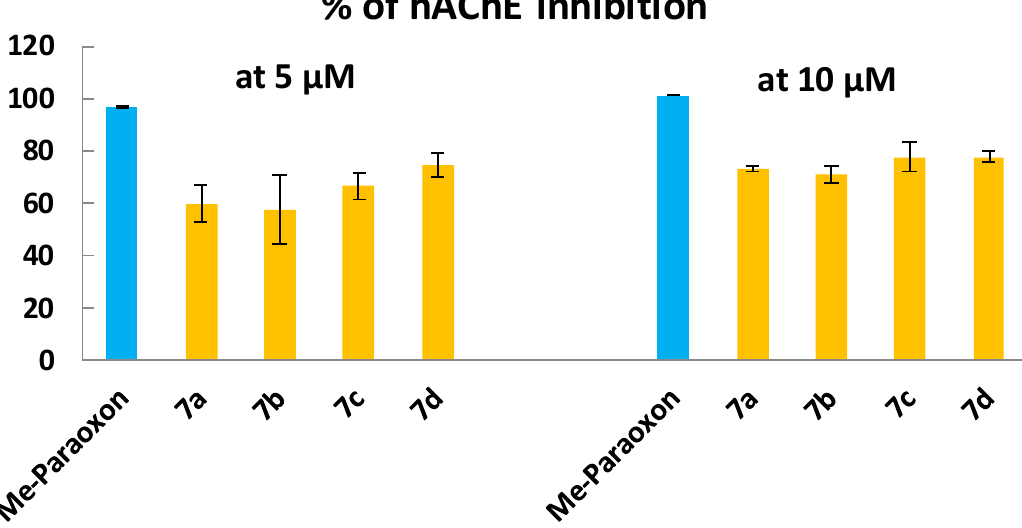
Figure 8. Experimental in vitro h AChE inhibition activities of the fused thiazolo[3,2- a ]pyrimidines 7a – d and the positive control, methyl paraoxon, at 5 and 10 µ M. The data are expressed as average ± standard deviation of two independent experiments.